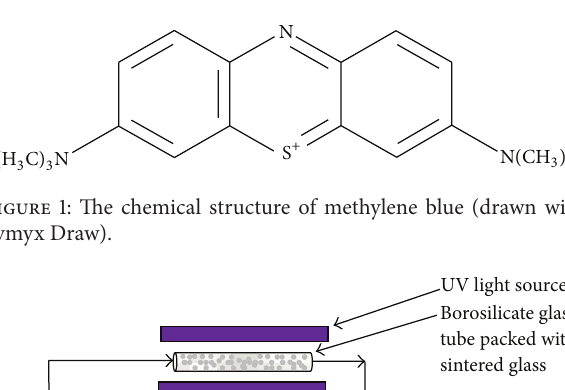
Figure 3: Photocatalytic